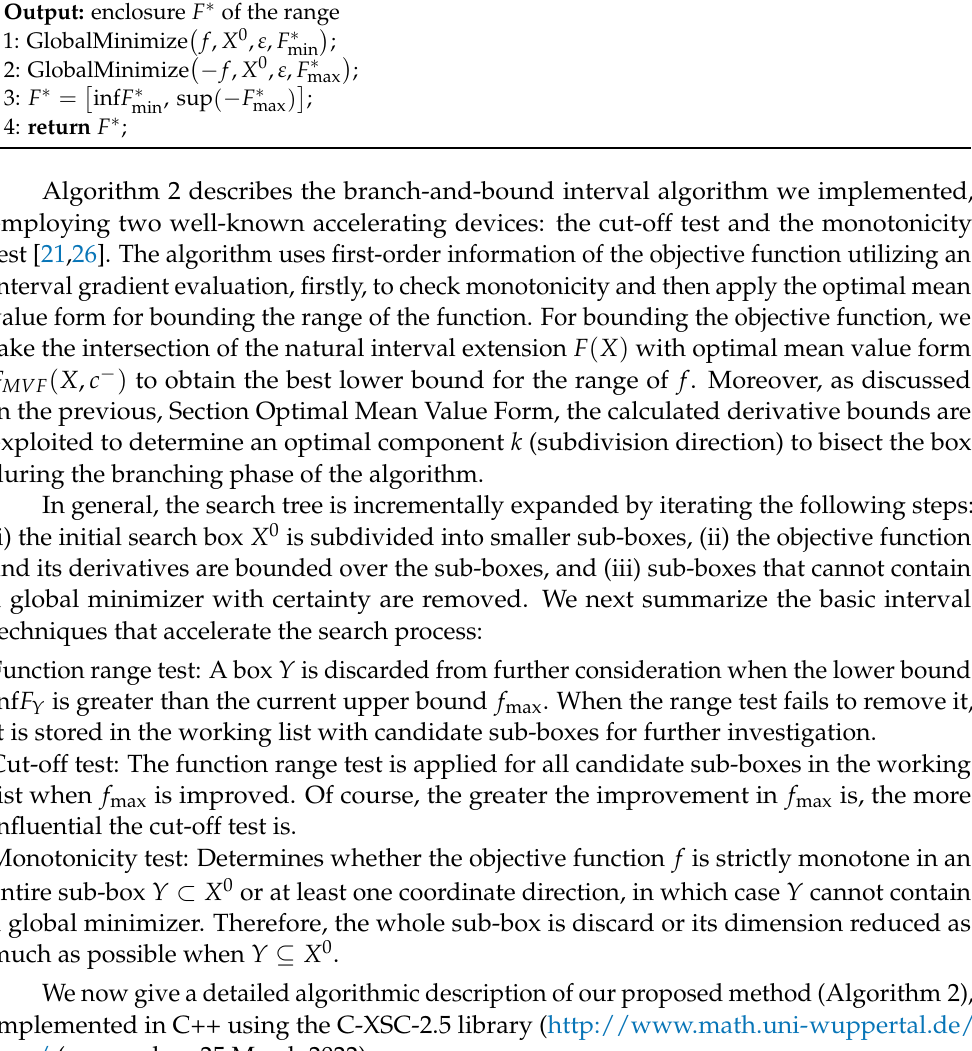
Algorithm 1 . ComputeRange